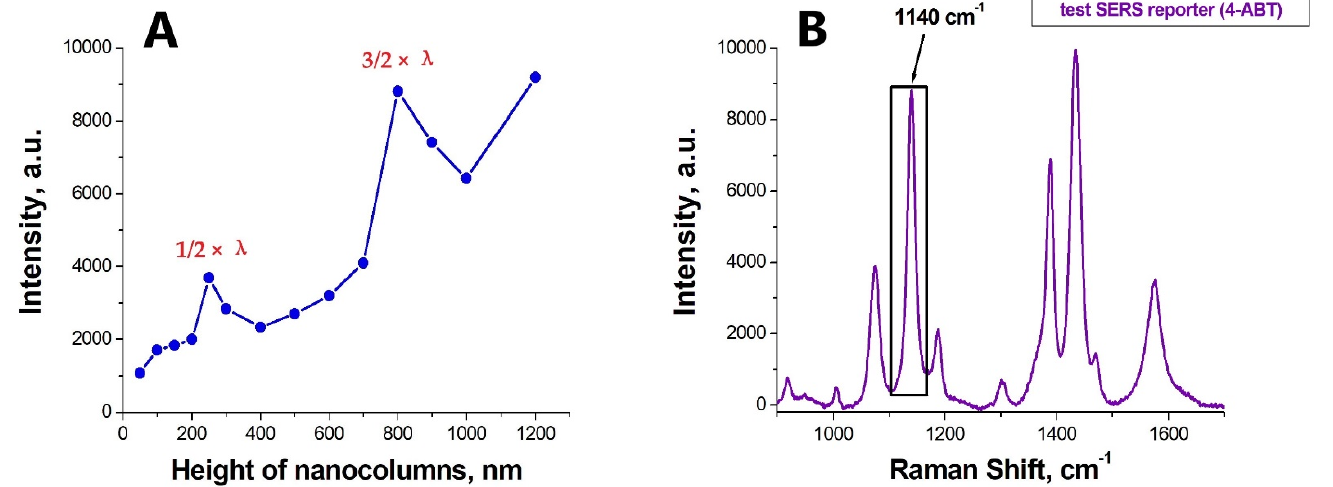
Figure 2. The effect of the dielectric nanocolumn height on the Raman signal amplification. ( A ) the dependency of the integral intensity for the 4-ABT substance line in the spectral window of 1120–1170 cm − 1 , measured at 80 nm thickness of the deposited silver layer on top of the nanocolumns. ( B ) The SERS spectrum for 4-ABT, obtained from a nanoperiodic structure, with the column height of 250 nm and the thickness of the deposited silver of 80 nm.